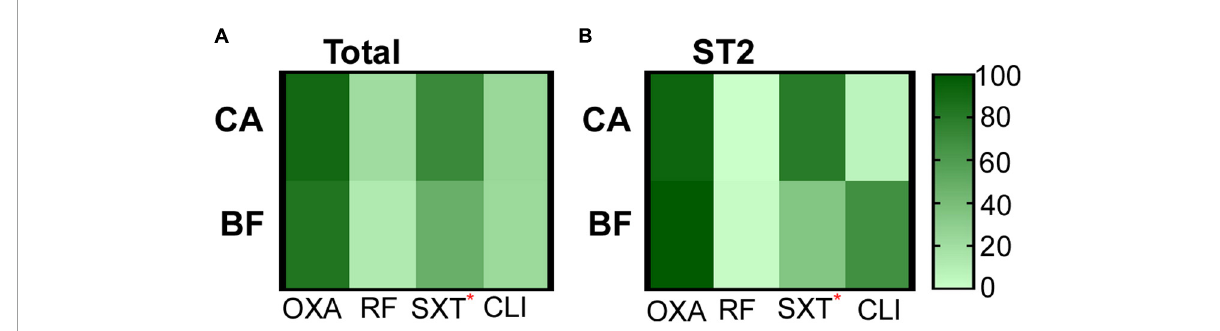
FIGURE2 The antibiotic resistance of strains isolated from different groups. (A) All S. epidermidis isolates. (B) ST2 isolates. CA, isolates from catheters; BF, isolates from sterile body fluids; oxicillin (OXA), rifampicin (RF), co-trimoxazole (SXT), clindamycin (CLI). The statistical significance was measured by Chi-Square test. * p < 0.05.